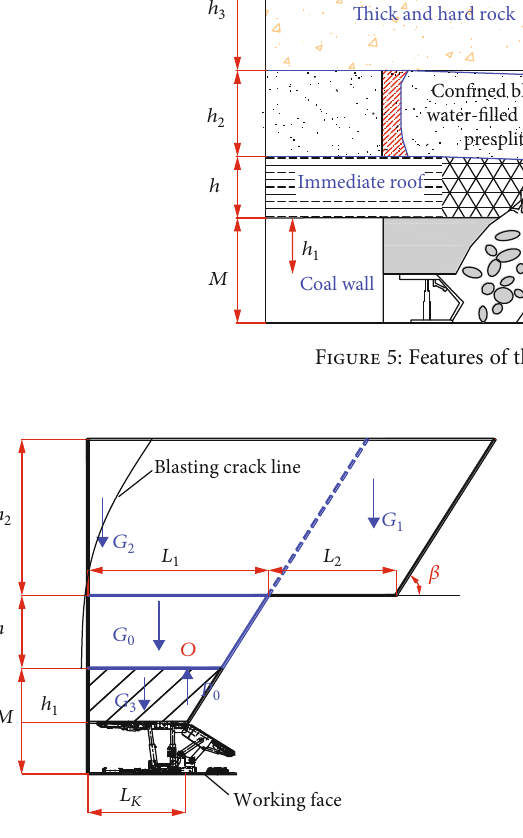
Figure 6: Calculation of the support load after precontrol.